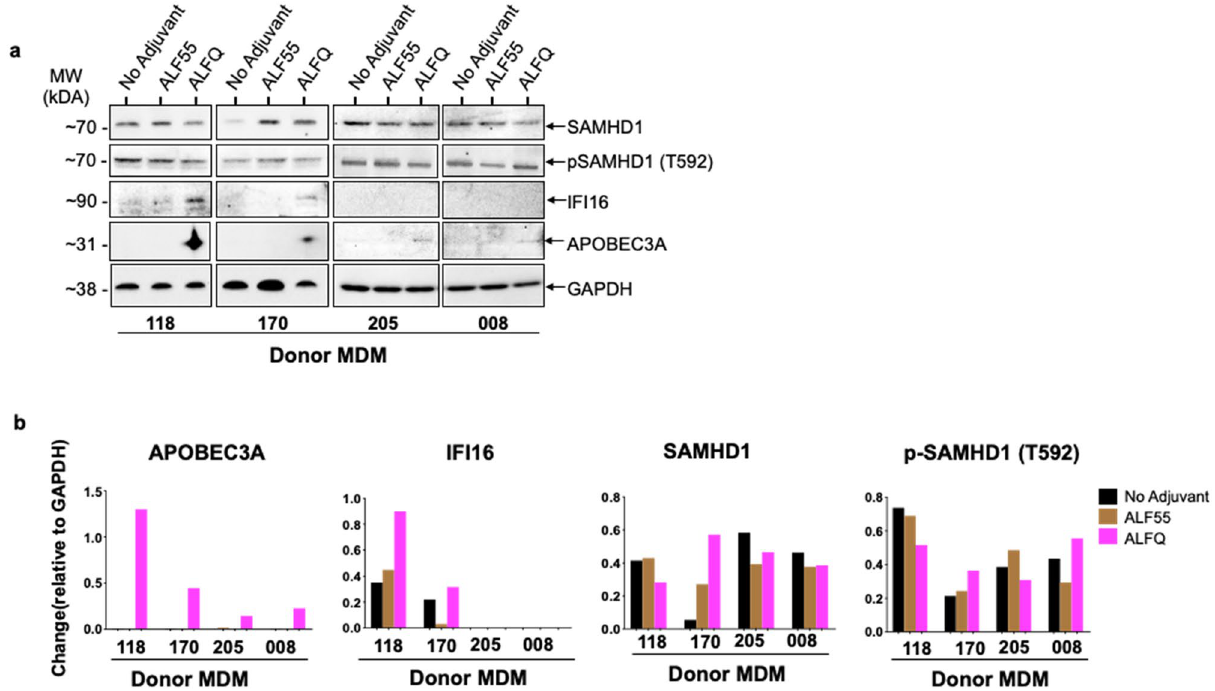
Figure 9. Protein synthesis of APOBEC3A and IFI16 is induced in ALFQ-treated MDM. Primary human monocytes were differentiated into MDM following in vitro culture with M-CSF media. At day 4 post-culture, the cells were treated with ALF55 or ALFQ for 24 h. Untreated (no adjuvant) MDM cultures served as controls. Cells were harvested, lysed, and analyzed by SDS-PAGE followed by Western blotting using antibodies against SAMHD1, phospho-SAMHD1, IFI16 and APOBEC3A. ( a ) Cropped images of the blots shows the presence of IFI16 protein and APOBEC3A protein only in lysates from ALFQ-treated MDM. ( b ) Densitometry analysis was performed on protein bands (APOBEC3A, IFI16, SAMHD1, and phospho-SAMHD1), and normalized to its corresponding GAPDH band. The original blots are presented in Supplementary Figs.